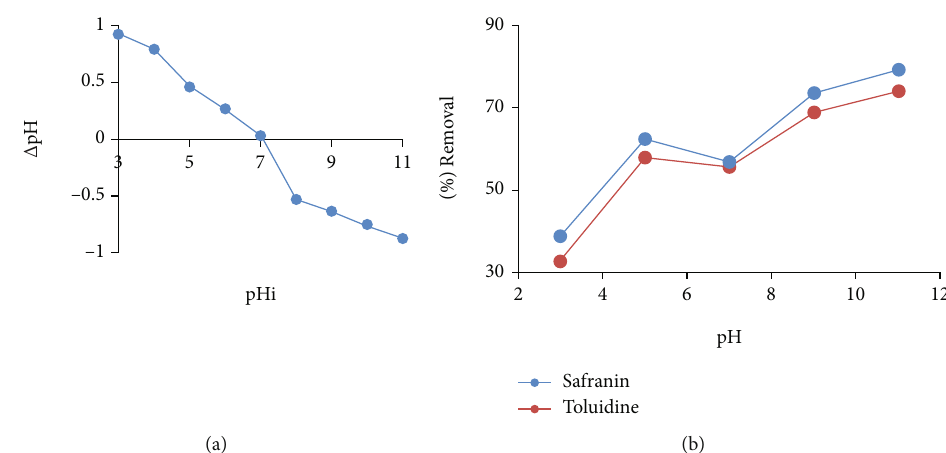
Figure 4: (a) Point of zero charge (conditions: temp 313 K, dose 0.01 – 0.005, time 24h, pH range (2 – 11) adjusted by 0.1M HNO NaOH, using NaNO 0.1N solution and volume 30mL) and (b) e ff ect of pH on the % removal of safranin and toluidine by 3